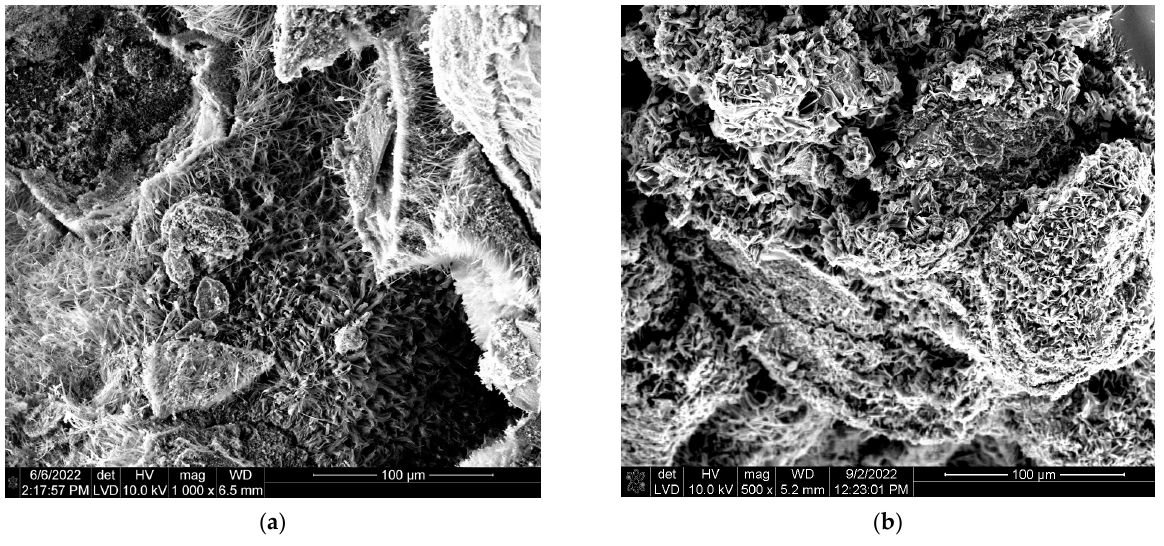
Figure 24. Microstructure of silicate bricks after 6 years (in 2022) from the laboratory production (in 2016); ( a ) microstructure of the laboratory bricks with 90% QS, 100 μ m magnification; ( b ) microstructure of the laboratory bricks with 90% GS, 100 μ m magnification. Table 2. EDS analysis results for a brick modified by 90% GS (after 36